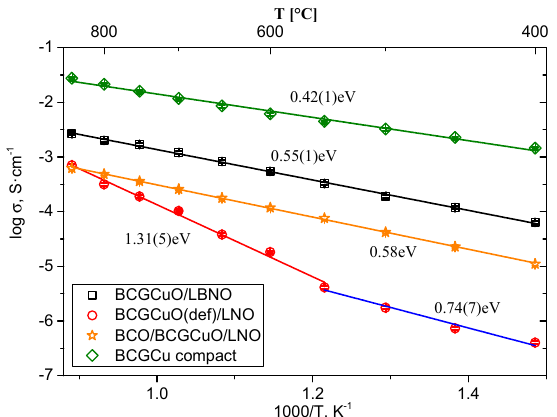
Figure 8. Arrhenius dependences of conductivity of the BCGCuO film deposited on the LBNO substrate, the deficient BCGCuO film deposited on the LNO substrate, the BCGCuO film with the protective BCO layer deposited on the LNO substrate and total conductivity of the BCGCuO compact sample.